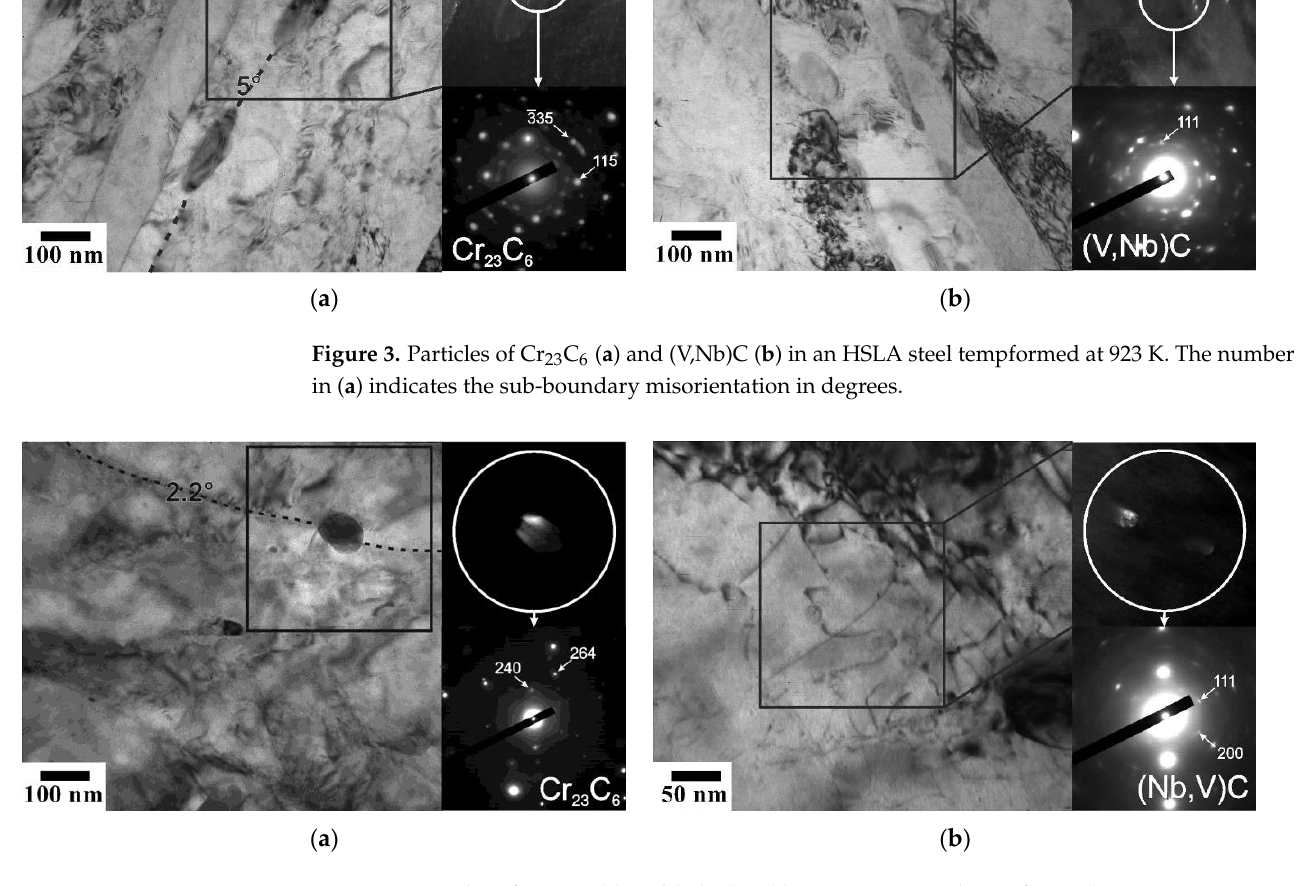
Figure 4. Particles of Cr 23 C 6 ( a ) and (Nb,V)C ( b ) in an HSLA steel tempformed at 973 K.